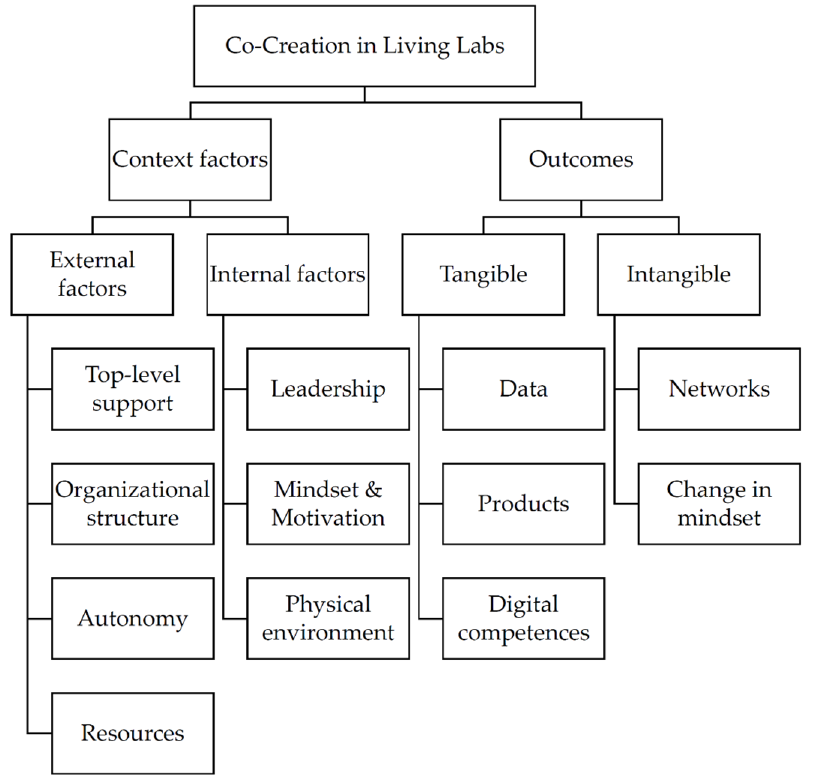
Figure 1. Summary of the coding results.